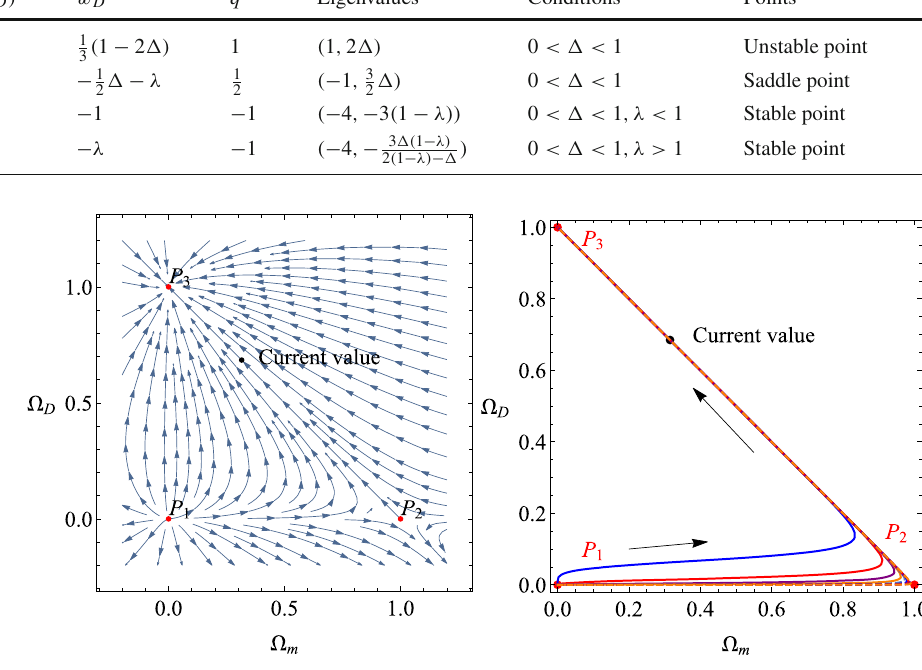
Table 2 Critical points and the stability conditions of IBHDEHL Label